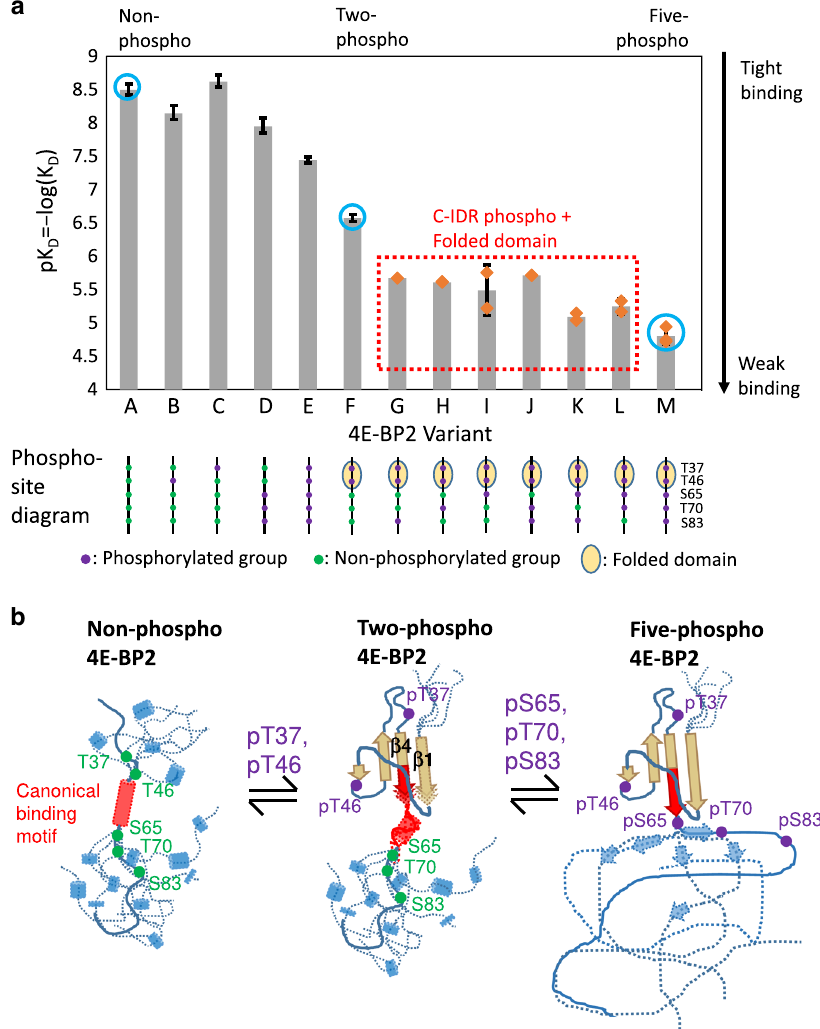
Fig. 6 4E-BP2 phosphorylation tunes eIF4E binding. a Phospho-dependent eIF4E-binding af fi nities. The eIF4E:4E-BP2-binding af fi nities for different 4E- BP2 variants are plotted as p K D = − log( K D ) for (A) non-phospho, (B) pT46 (T37A/S65A/T70A/S83A), (C) pT37 (T46A/S65A/T70A/S83A), (D) C-IDR phospho pS65/pT70/pS83 (T37A/T46A), (E) 5-phospho Gly-to-Val double mutant: G39V/G48V pT36/pT46/pS65/pT70/pS83, (F) two-phospho pT37/pT46 (S65A/T70A/S83A), (G) pT37/pT46/pS83 (S65A/T70A), (H) pT37/pT46/pT70 (S65A/S83A), (I) pT37/pT46/pS65 (T70A/S83A), (J) pT37/pT46/pT70/pS83 (S65A), (K) pT37/pT46/pS65/pS83 (T70A), (L) pT37/pT46/pS65/pT70 (S83A), and (M) fi ve-phospho pT37/pT46/ pS65/pT70/pS83. The K D values and their uncertainties are from this work (G – M) or Bah et al. 11 (A – F, M) (see Supplementary Fig. 7) and were measured using ITC as the mean and standard deviation of sample repeats (see “ Methods ” section). Repeat data collections ( n = 3 for 5p-4E-BP2; n = 2 for pT37/ pT46/pT70, pT37/pT46/pS65, pT37/pT46/pT70/pS83, pT37/pT46/pS65/pS83, pT37/pT46/pS65/pT70; n = 1 for pT37/pT46/pS83 due to sample and data quality) were taken from different samples, some from the same preparation and others from different preparations. Individual K D values found for this paper (G – M) are indicated with orange diamonds. The af fi nities for np-4E-BP2, 2p-4E-BP2, and 5p-4E-BP2 are marked in the chart with blue circles. Schematic cartoons for each of the 4E-BP2 variants are shown at the bottom of the chart in which green circles indicate non-phosphorylated sites, purple circles are phosphorylated residues, and the tan oval represents the folded domain of 4E-BP2. b Schematic representation of three-stage phospho- regulation of 4E-BP2:eIF4E binding. Cylinders and arrow represent helices and β -strands, respectively. The disordered np-4E-BP2 and C-IDR of phospho 4E-BP2 is shown as multiple dashed lines with a single polypeptide highlighted as a solid line. Apo np-4E-BP2 is pre-ordered, albeit transiently, in eIF4E- binding helical form. The canonical binding motif is highlighted in red and the unphosphorylated site are marked as green spheres. pT37/pT46 (shown as purple spheres) phosphorylation triggers folded domain formation, tucking part of the binding residues into the β -sheet as β 4, with β 1 between it and the edge of the β -sheet. Some helical propensity remains in the C-terminal end of the binding motif. pS65/pT70/pS83 phosphorylation further shifts conformational propensities toward β -strand. β 1 and β 4 are lengthened and stabilized in the folded domain, sequestering the rest of the binding (Fig. 8a, b). Con fi rming the validity of these statistics, hairpin Beyond the enrichment of glycine at i + 3, we observe that T or mutations, which we tested in 4E-BP2, exhibited effects corre- S at i and P at i + 1 are also associated with an increased hairpin sponding to their prevalence in similar turns within the PDB. propensity, with 2640 unique [TS]P-containing hairpins found in Fold-compatible mutants, 37 pTPGGR and 37 TPGGA, are found the PDB. This suggests that the structurally similar turns found in constitutively folded proteins can include a proline-directed in similar turns and fold-destabilizing mutants, 37 pTPIGT, 37 pTPGPT, 37 pTPGWT, and 37 pTPGVT, are excluded. phospho-site, and that the stability of these folds could be